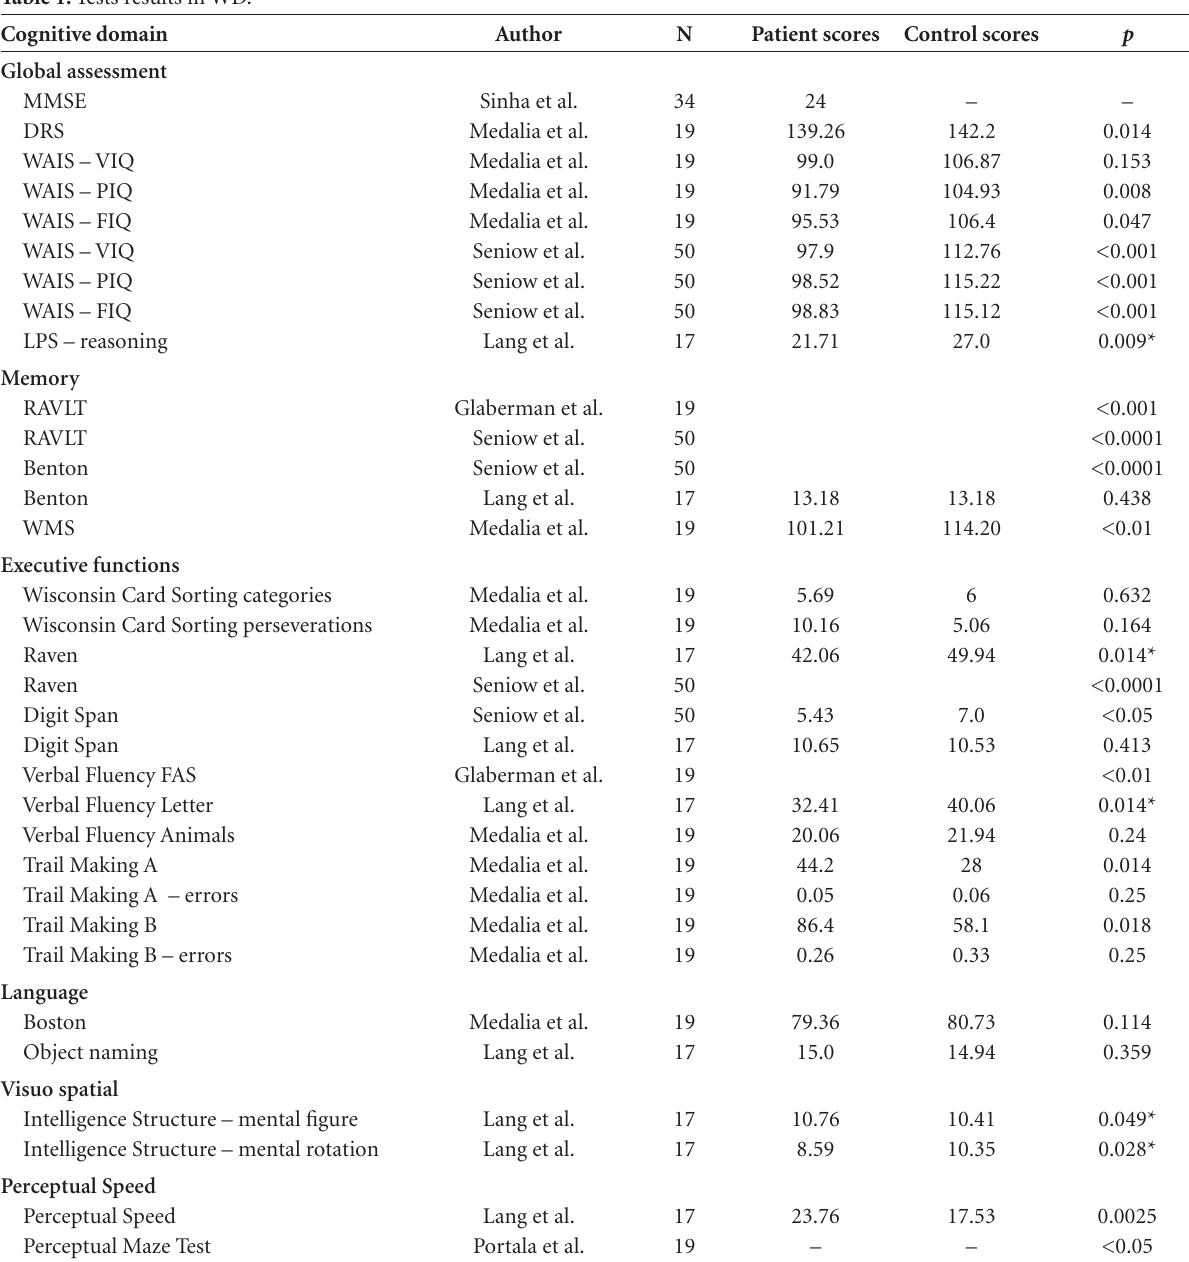
Table 1. Tests results in